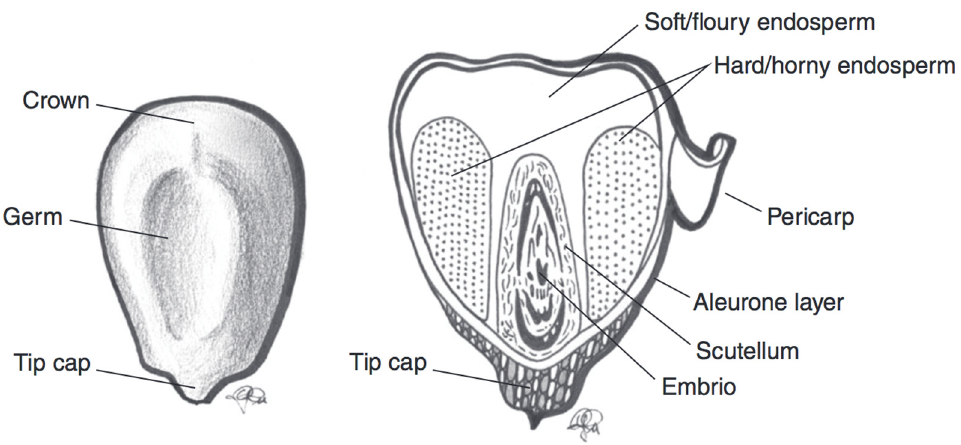
Figure 4. Schematic representation of a maize kernel cross-section, with component parts. Adapted from reference [27].